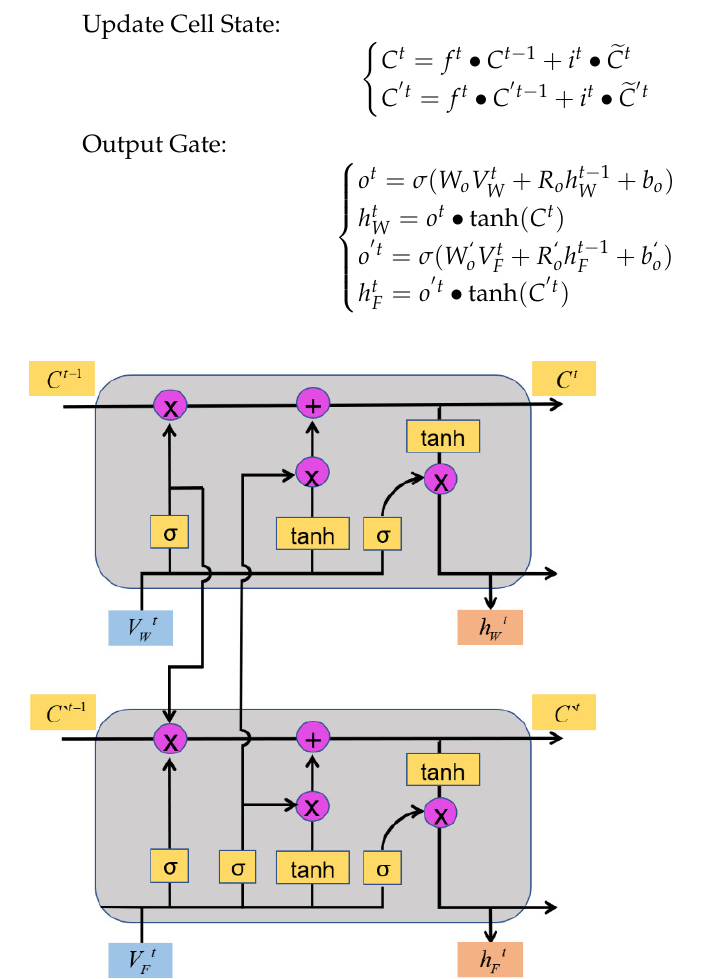
Figure 4. The neuron unit structure of